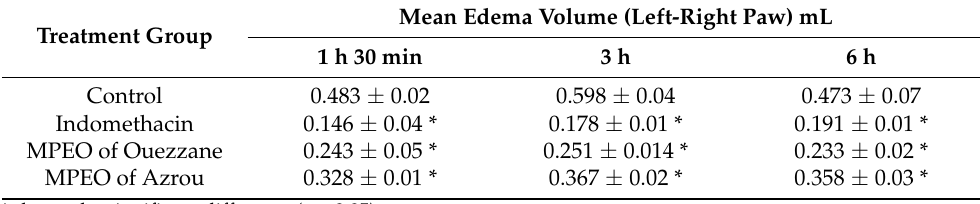
Table 4. Effect of M. pepirita essential oils on carrageenan-induced rat paw edema. Treatment Group